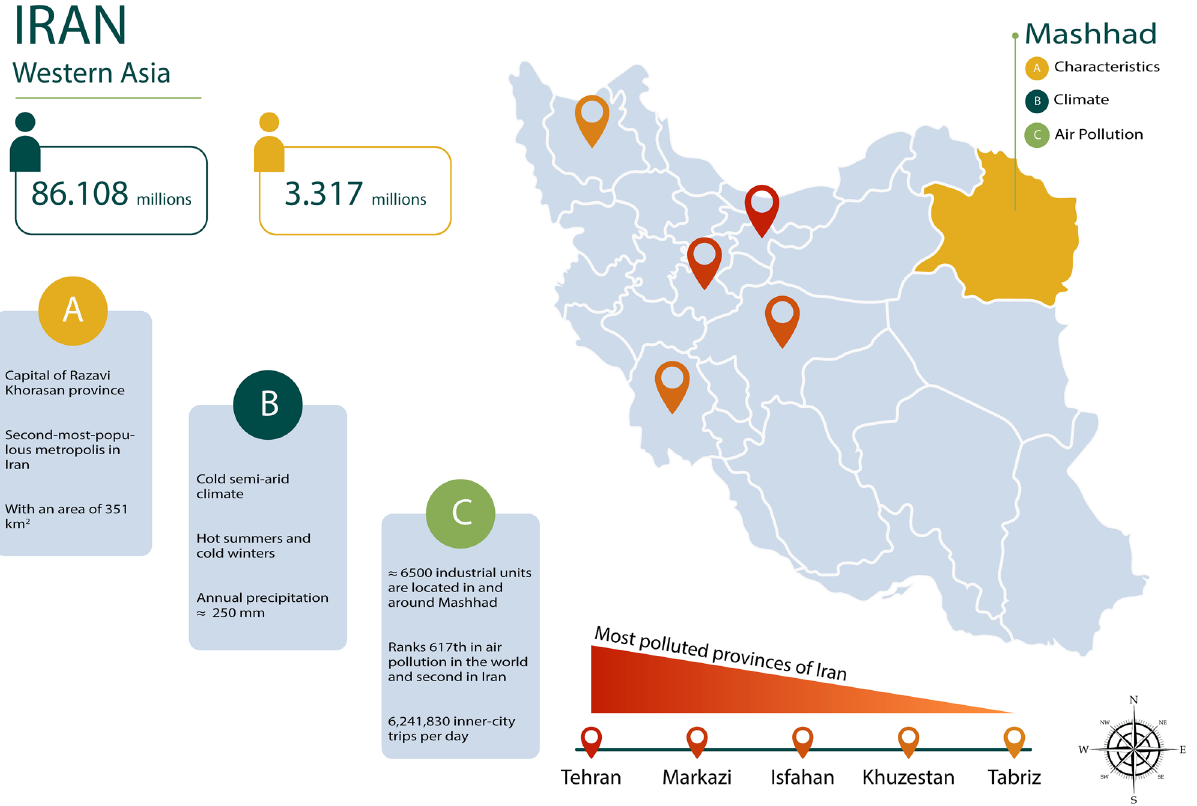
Figure 8. Map of Iran and study area in Mashhad along with features of city. The most polluted provinces of Iran are included on the